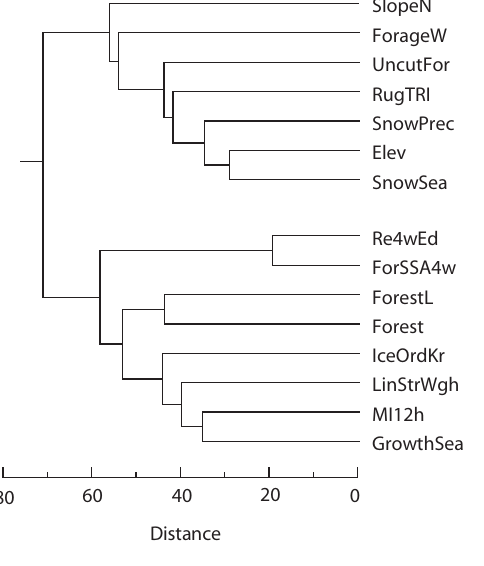
Fig. 4. Scree plot showing the variance described by the first 10 PCs in a PCA including the 15 retained variables (solid line). Dotted line shows average scree plot of 10 000 simulations on 15 uncorrelated variables, and 1958 observations.